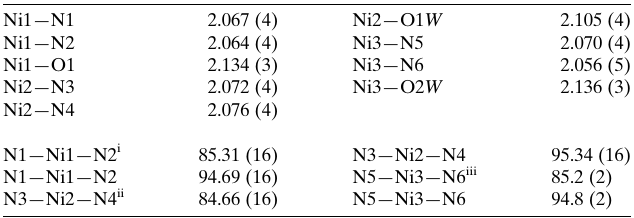
Table 1 Selected geometric parameters (A˚ , (cid:4)